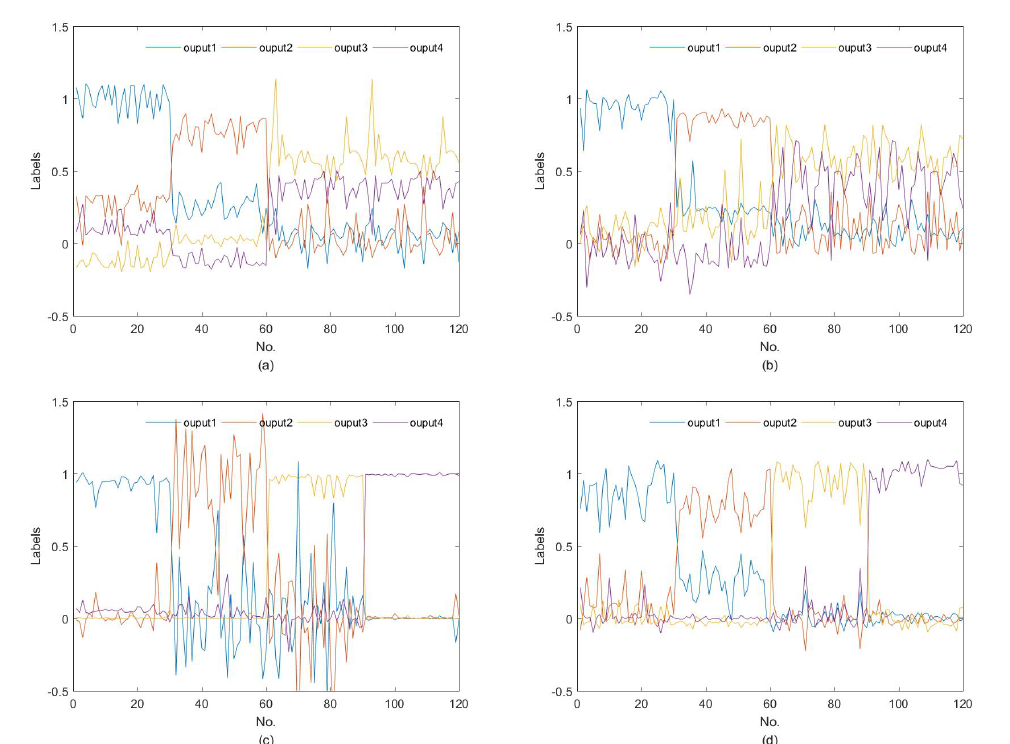
Figure 11. Test results of the BP neural network where the features used were extracted from ( a ) the vibration signals of six sensors; ( b ) the first IMF of six sensors; ( c ) reconstructed vibration signals using the proposed sensitive IMF collection method; ( d ) reconstructed vibration signals using the proposed feature fusion